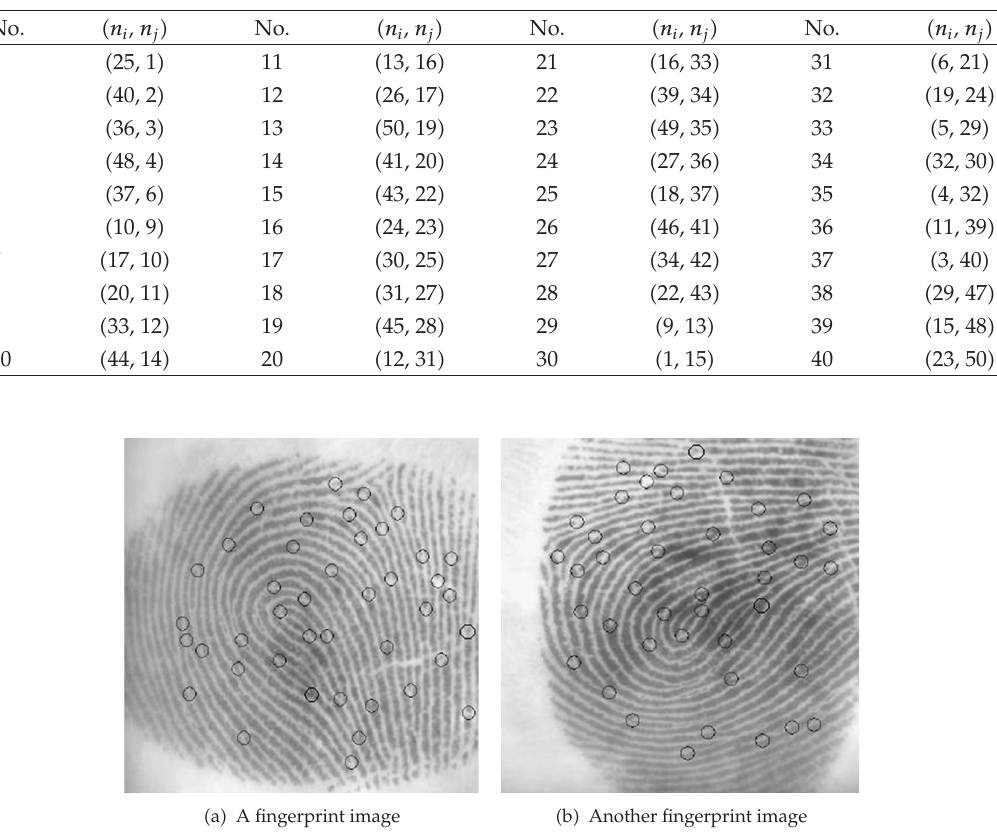
Table 5: Matched pairs (cid:6) n i , n j (cid:7) between Tables 1 and 4, where n i and n j are the serial numbers of points in Tables 1 and 4.